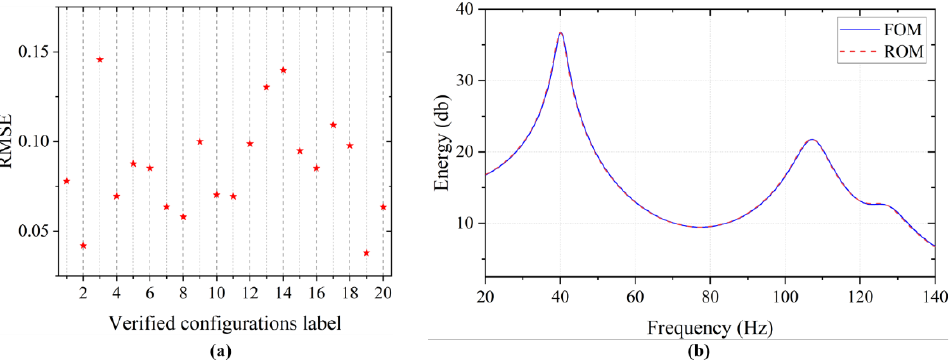
Figure 17. Accuracy of the verified configurations computed by updated global POD ROM: ( a ) RMSE values; and ( b ) energy–frequency curves of No.3 verified configuration.